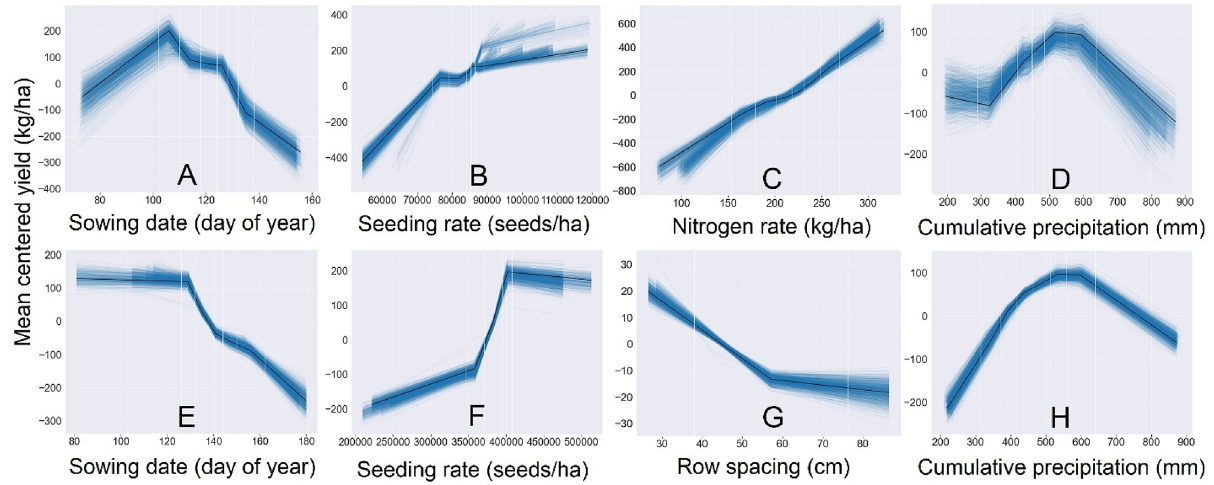
Figure 3. Accumulated local effect plots for maize sowing date ( A ), seeding rate ( B ), Nitrogen fertilizer rate ( C ), and cumulative precipitation between June and September (mm) ( D ), and soybean sowing date ( E ), seeding rate ( F ), row spacing ( G ), and cumulative precipitation between June and September (mm) ( H